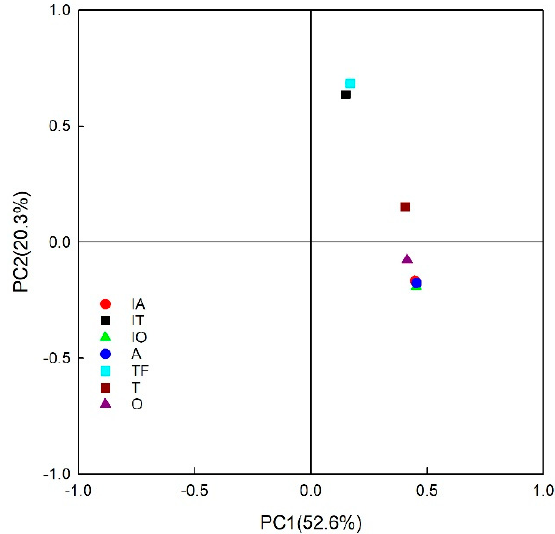
Figure 7. Biplots of component analyses using (PROC PRINCOMP) to identify relationships among the variables. IA: image appearance; IT: image texture; IO: image overall quality; A: real appearance; TF: real texture firmness; T: real texture; O: real overall quality .